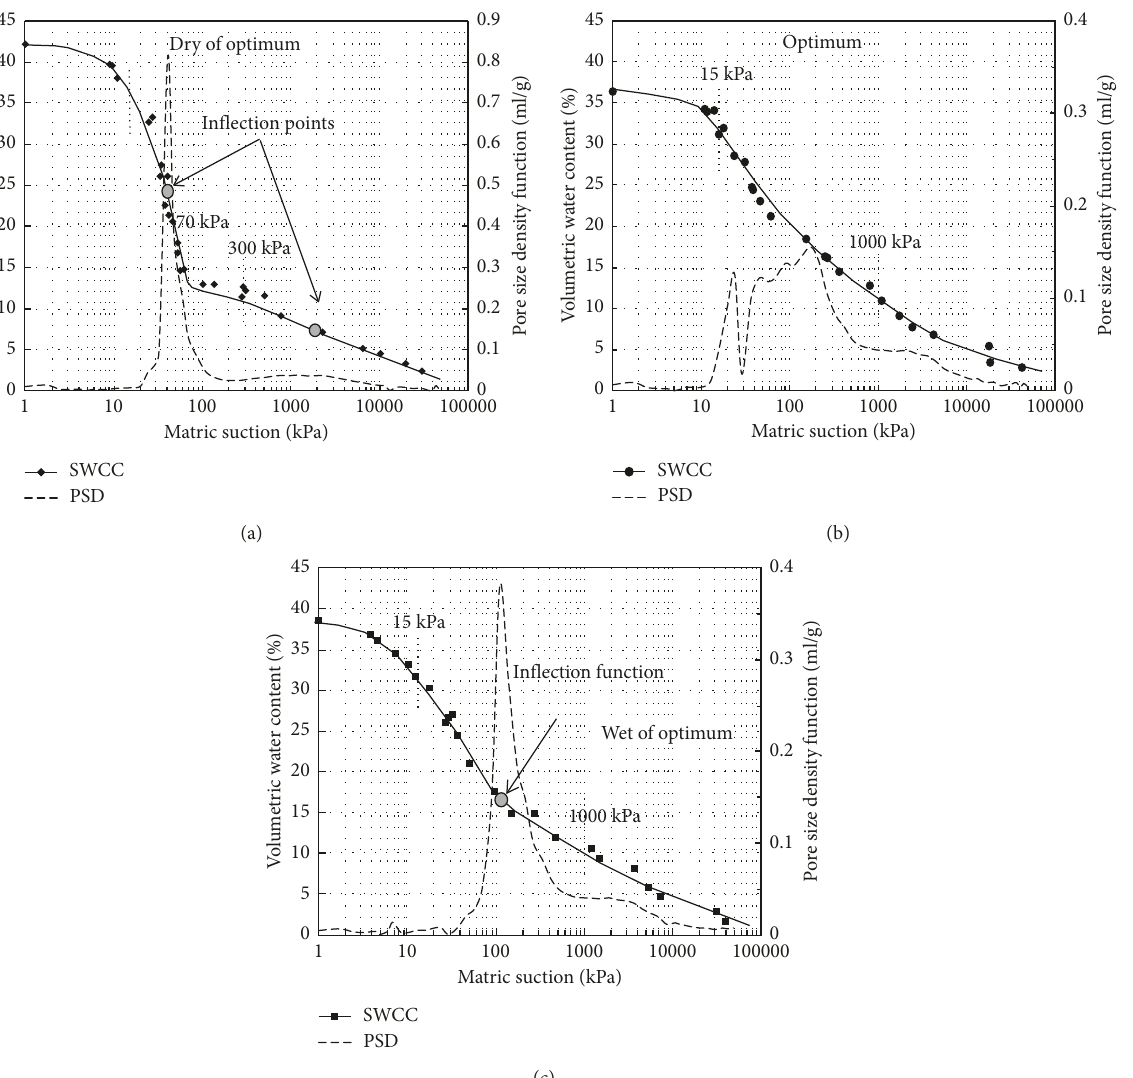
Figure 14: Measured SWCCs and pore size (converted to suction) density functions of loess compacted at different initial water contents: (a) dry of optimum water content (8%); (b) optimum water content (17%); and (c) wet of optimum water content